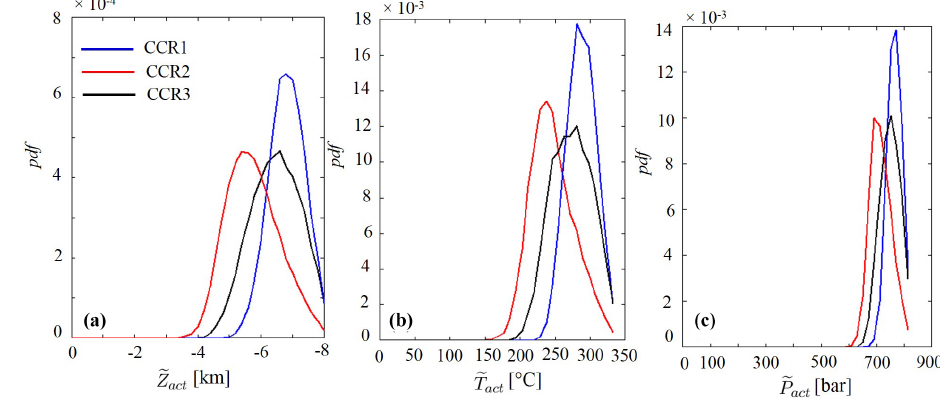
Figure 6. Probability density functions (pdfs) of (cid:101) T act (a) , (cid:101) P act (b) and (cid:101) Z act (c) evaluated for CCR1 (solid blue line), CCR2 (solid red line) and CCR3 (solid black line) at t = 0Ma.